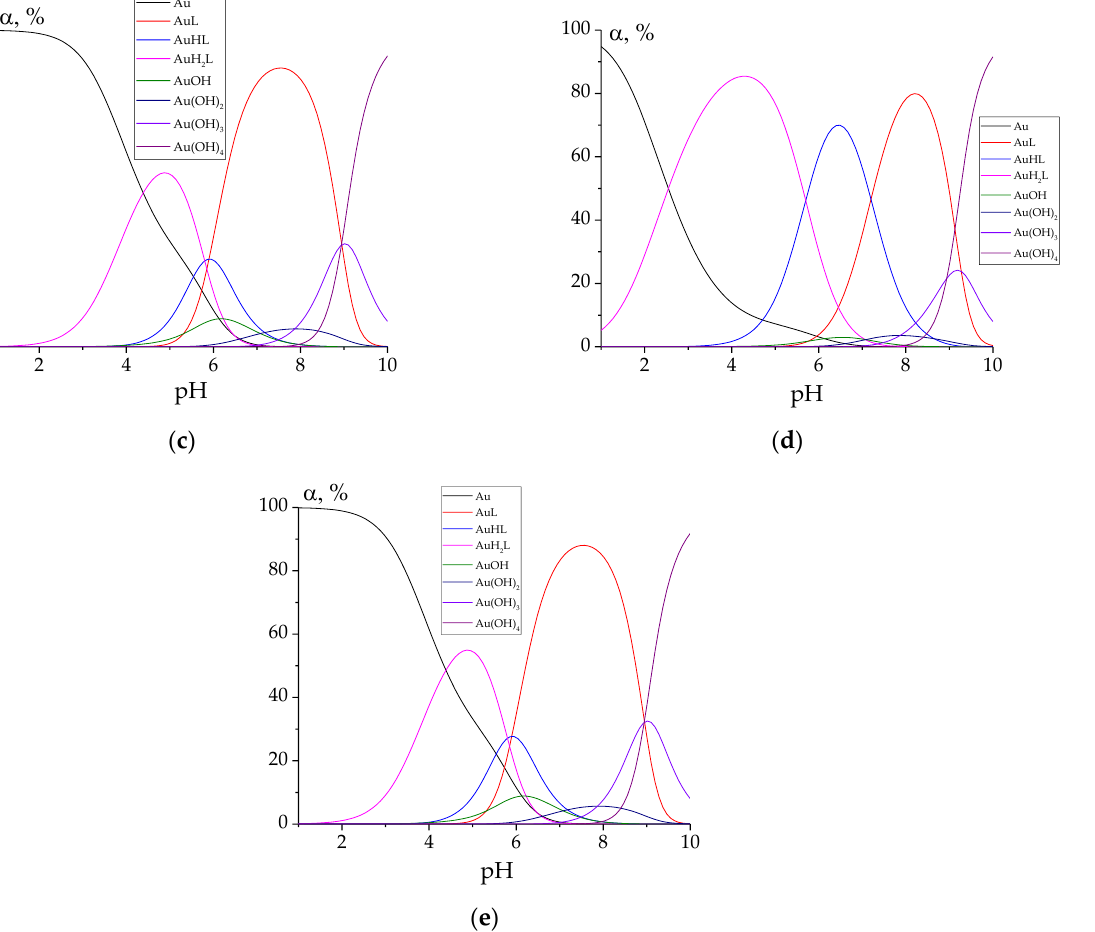
Figure 5. Speciation diagrams for the solutions containing 0.0001 mol L −1 of HAuCl 4 and 0.0001 mol L −1 of hydrazones: PLP-INH ( a ); PLP-F2H ( b ); PLP-F3H ( c ); PLP-T2H ( d ); PLP-T3H ( e ). ‘Au’ denotes tetrachloroaurate.